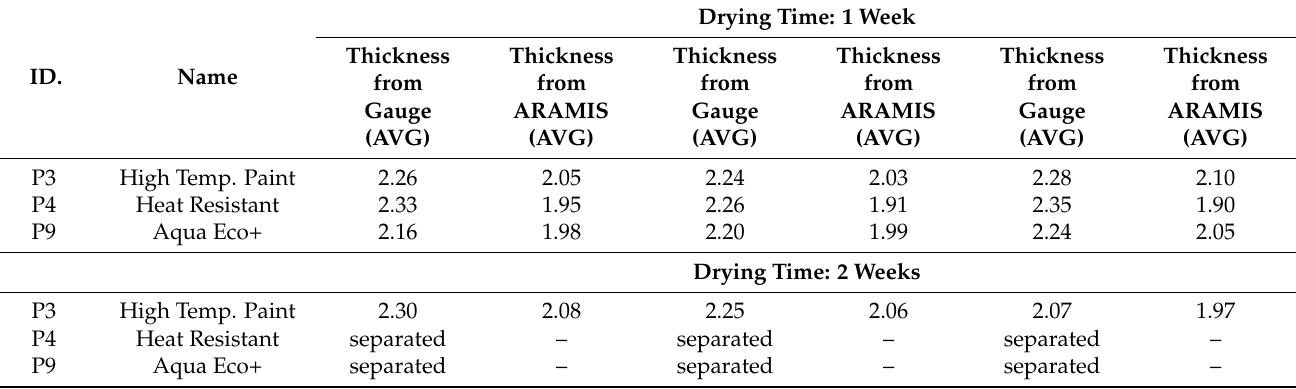
Table 13. Measurement results of usability tests (material: Al2, surface preparations: SC1, SC4, and SC9).